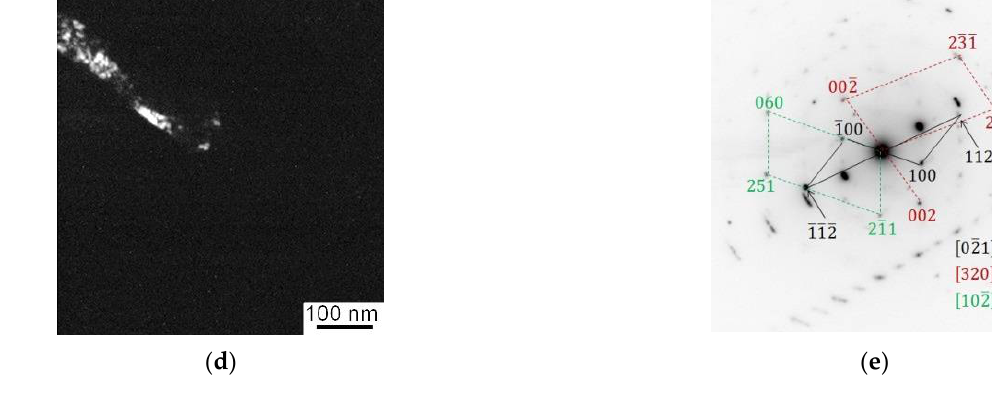
Figure 5. TEM bright- ( a ) and dark-field ( b – d ) images and an associated SAED pattern with an indexing scheme ( e ) illustrating the microstructure of the Ti-6Al-4V samples subjected to UIT. The TEM micrographs were obtained at a depth of 10 µ m below the treated surface. The dark-field micrographs were obtained with the 100 α -Ti ( b ), 211 α (cid:48)(cid:48) -Ti ( c ) and 002 β -Ti ( d ) reflections. According to Figure 6a, the enhanced translational movement in easy-sliding direc- tions precedes less pronounced fragmentation of the original α grain structure at a depth of 45 µ m below the treated surface. A marked difference in orientations between adjacent α -Ti subgrains is evidenced by dark-field TEM micrographs (Figure 6b,c). The dislocation cell structure inside the elongated subgrains is visible.